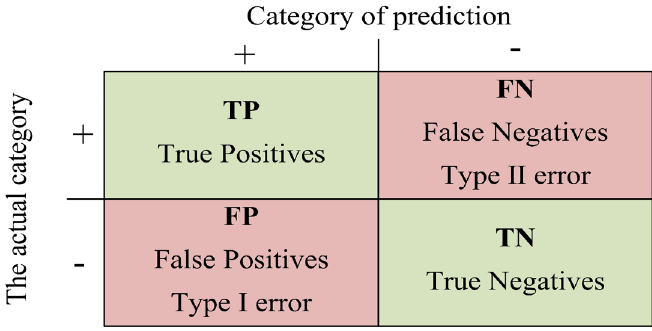
Figure 12. Confusion matrix structure.